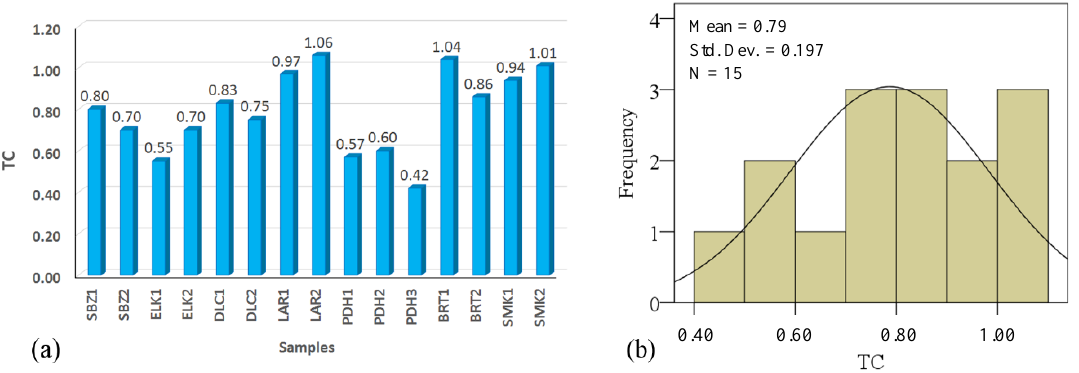
Figure 8. ( a ) Diagram of the texture coefficient (TC) values and ( b ) histogram of the TC for the studied rock samples.